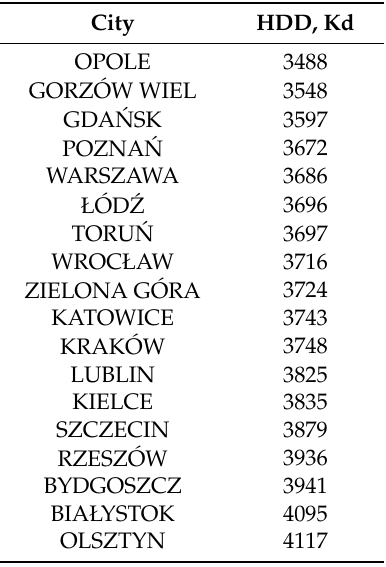
Table 3. The number of heating degree days (HDD) for main Polish